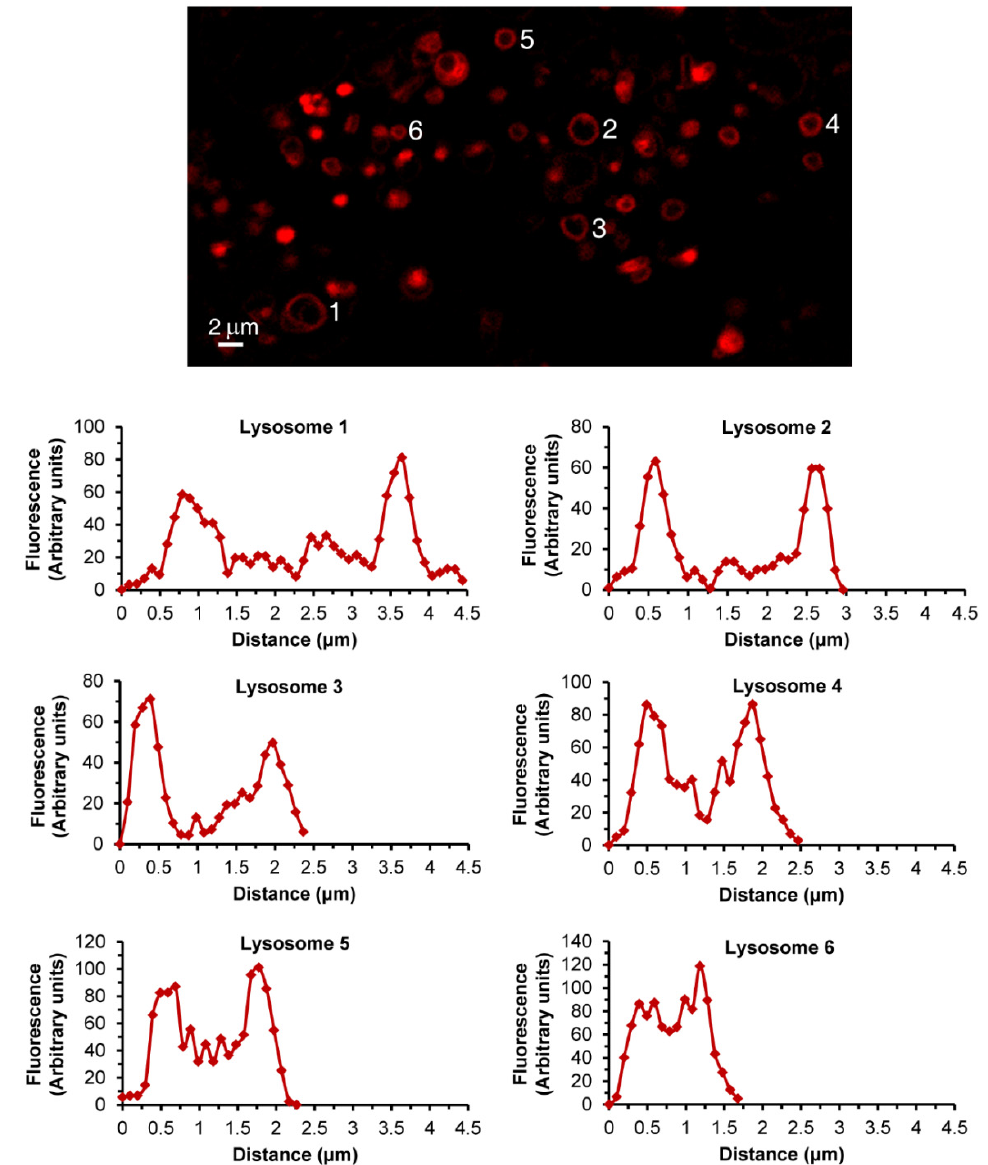
Figure 4. Lysosomal DNR fluorescence analysis. Vacuolin-1-treated U2OS cells were loaded for 45 min with DNR and imaged with a confocal Zeiss LSM 710 microscope ( × 63 magnification). Individual lysosomes were analyzed for fluorescence intensity along their diameter using the ImageJ software. Each graph corresponds to a lysosome numbered in the photo.